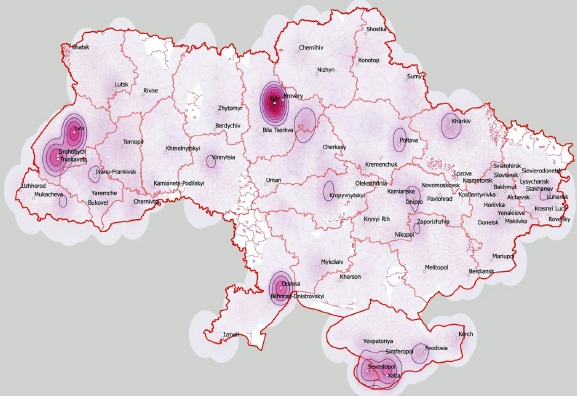
Figure 8. A heatmap (the distribution of museums on the territory of Ukraine)